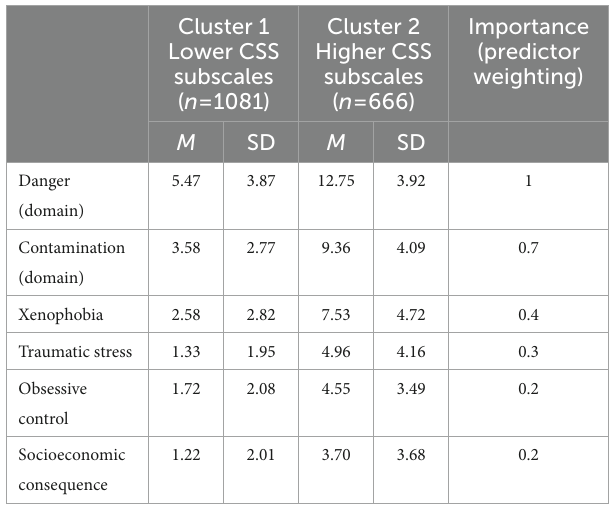
TABLE 2 Mean values and standard deviations of the subscales of the CSS, divided by cluster classification, sorted by predictor